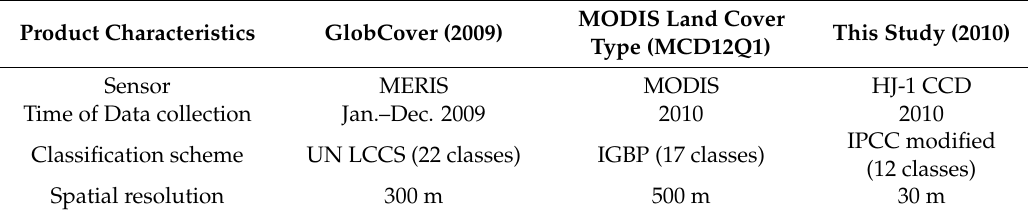
Table 2. Characteristics of land cover datasets used in this study.